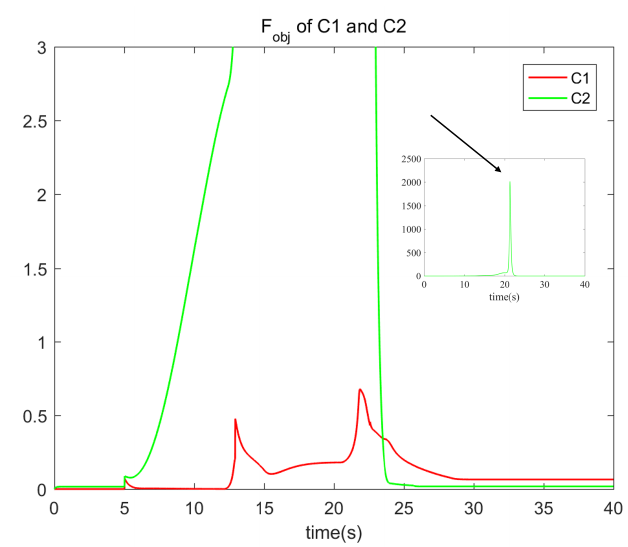
Figure 11. The objective function F obj for robots in formation with C1 and